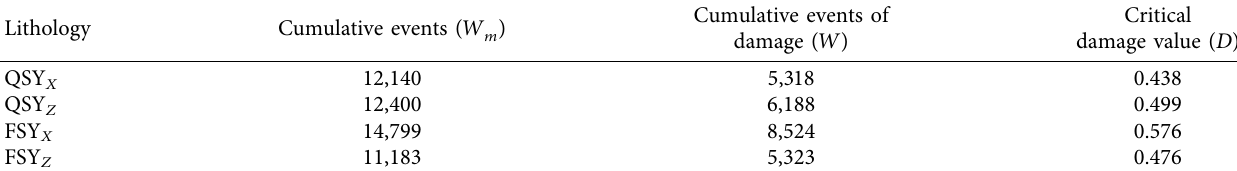
Table 3: Critical damage table of sandstone with different